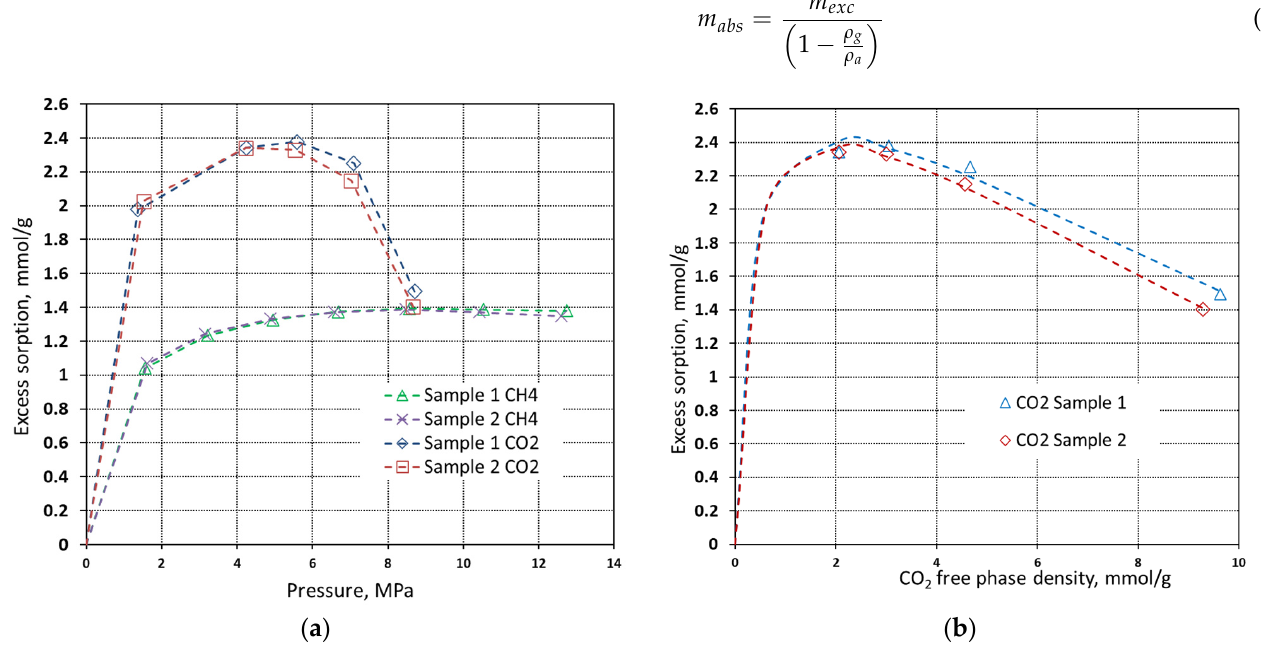
Figure 6. Carbon dioxide and methane sorption isotherms of pyrolyzed spruce wood measured at 40 °C ( a ) and plot of carbon dioxide excess sorption isotherms plotted against CO 2 free phase density with fitted Langmuir model (dashed line) ( b ).